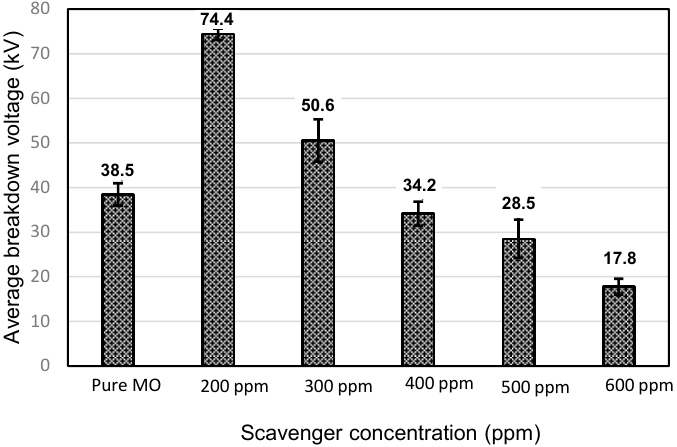
Figure 2. Comparison between the average AC breakdown voltage of the MO and those of the MO with different CCl 4 concentrations.